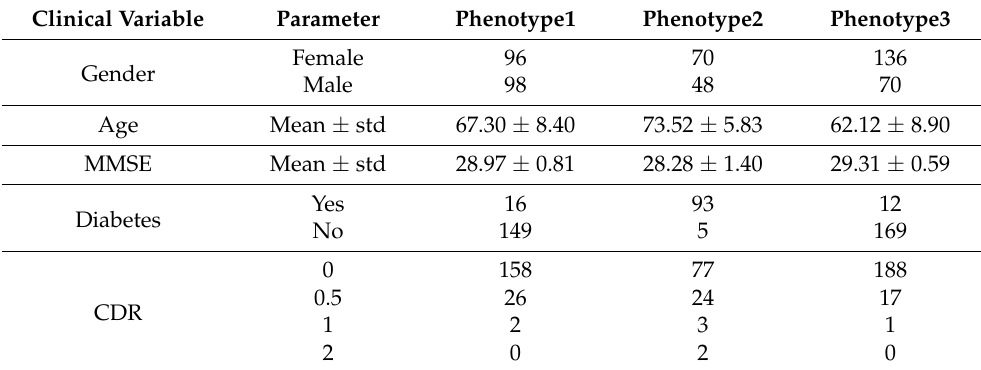
Table 3. Comparison of demographics and relevant clinical variables among the three A β -PET phenotypes that emerged from PP5.